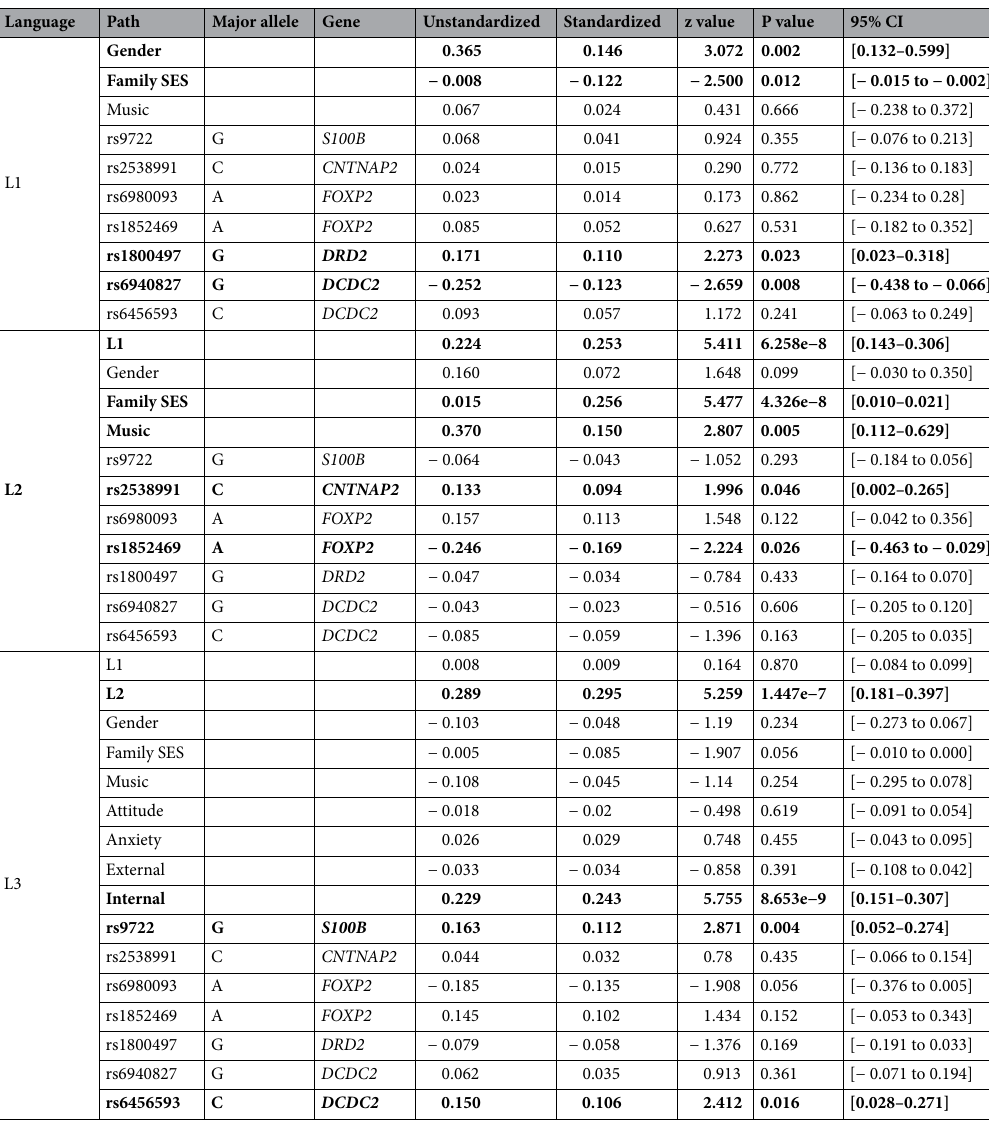
Table 6. Path coefficients of structural equation models (SEMs) for L1, L2, and L3. Gender and Music were coded as dummy variables with 1 = Female, 0 = Male; 1 = Have received at least 1 year of musical training, 0 = Have received less than 1 year of musical training or have not received any musical training at all. Both unstandardized and standardized beta coefficients between the two variables indicated by the path were reported. L1, L2, and L3 are latent variables of language proficiency with Chinese HKDSE grades, English HKDSE grades, and L3 Global scores as their indicators, respectively. In total, 609 participants were included in the SEM. Significant values are in